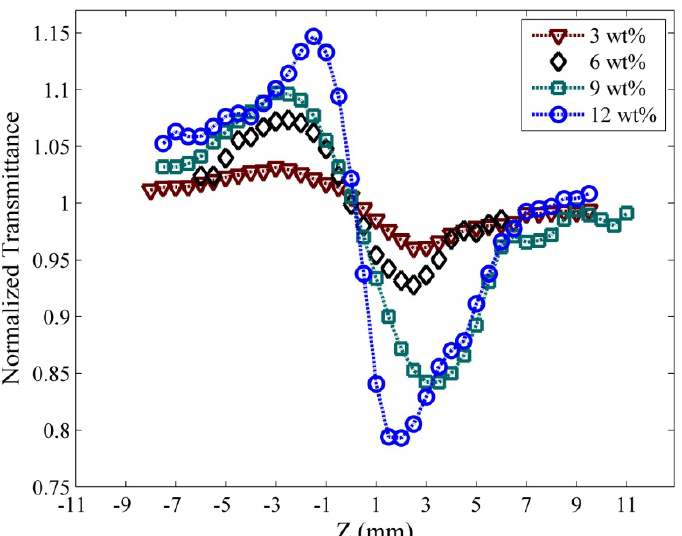
Figure 4. Normalized Z-scan transmittance curves of closed-aperture for PPy/MWNT for different MWNT (wt %)